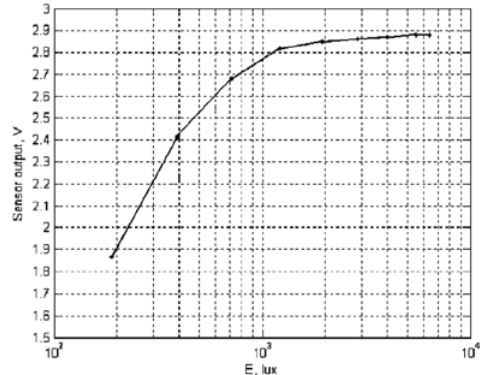
Fig. 2. Experimental assembly to calibrate incandescent lamp: